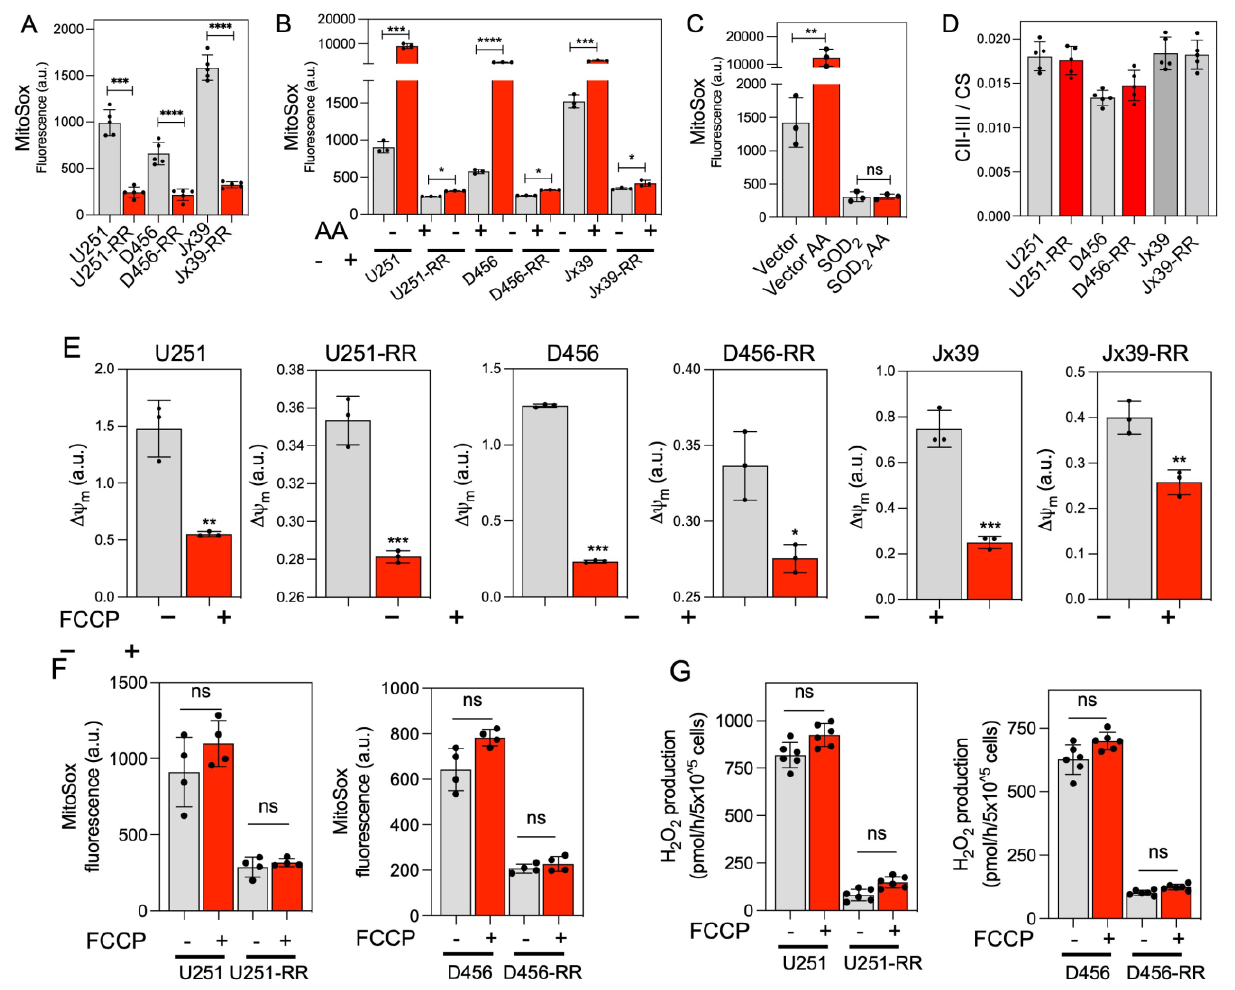
FIGURE 4: ROS production is lower in GBM cells with acquired radioresistance. (A) Quantification of mitochondrial O 2 ● - production in radio- sensitive (U251, D456, and Jx39) and isogenic radioresistant (U251-RR, D456-RR, and Jx39-RR) cell lines, determined by MitoSOX assays. Data are presented as the mean ± SEM (n=4). (B) Quantification of mitochondrial O 2 ● - production in the radiosensitive and radioresistant cells